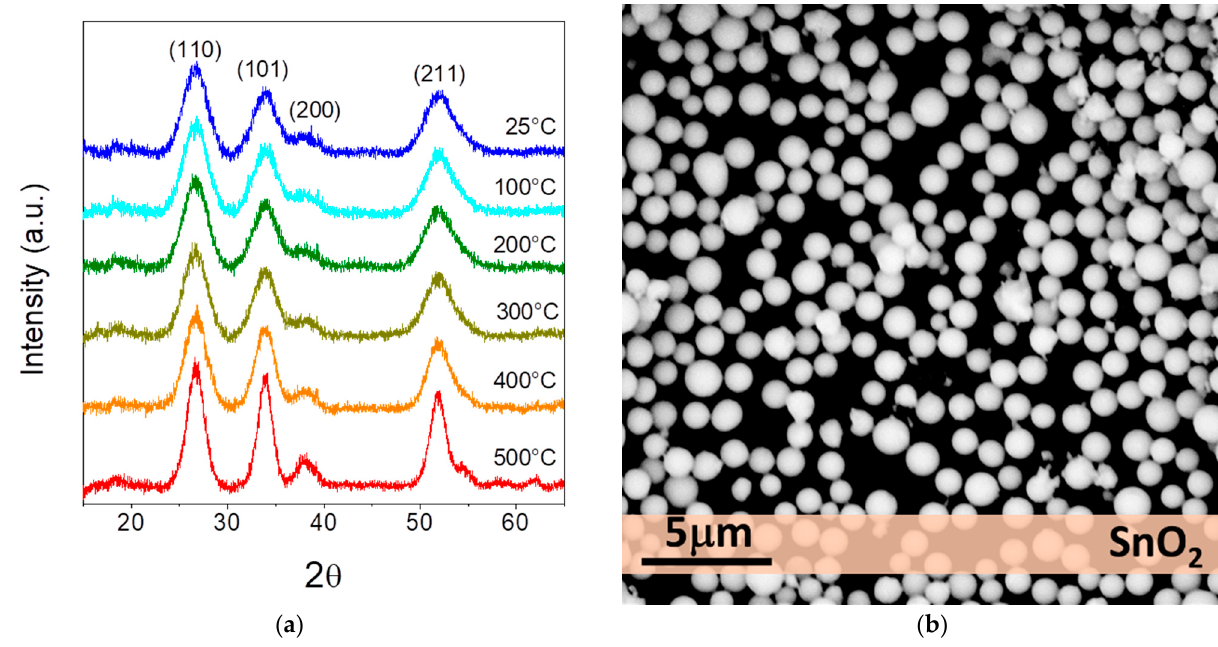
Figure 2. ( a ) XRD diffractograms versus temperatures and ( b ) SEM image of SnO 2 synthesized sample.